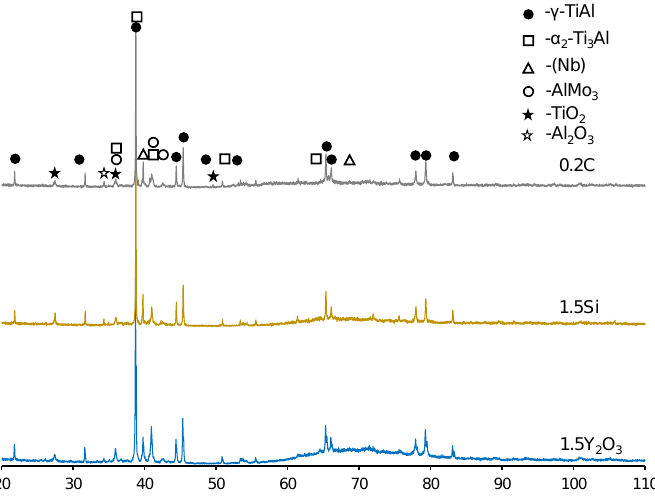
Figure 5. The XRD patterns of the 0.2C, 1.5Si, and 1.5Y 2 O 3 alloys’ oxidized layers after annealing at 800 °C. Table 3. The phase composition of the 0.2C, 1.5Si, and 1.5Y 2 O 3 alloys after oxidation annealing at 800 °C.